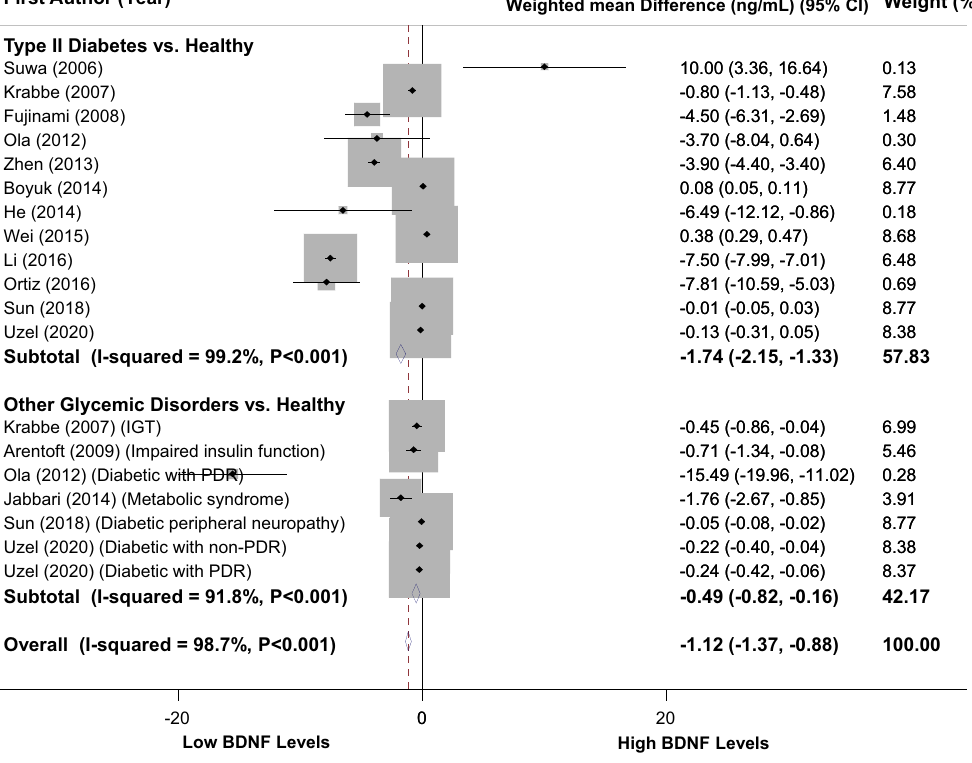
of 1306 diabetic or other glycemic disorders cases vs. 1250 healthy controls were included in this analysis. Over- all weighted mean difference (WMD) of BDNF levels in patients with T2D (or other glycemic disorders) was 1.12 ng/mL lower than healthy subjects (WMD: − 1.12; 95%CI − 1.37, − 0.88), which was statistically significant. Heterogeneity between included studies was observed (I 2 = 98.7%, P < 0.001); therefore, subgroup analysis based on the type of glycemic disorders was done (Fig. 2). In patients with T2D, BDNF levels were lower than healthy controls (WMD: − 1.74 ng/mL; 95%CI − 2.15, − 1.33). Also, subjects with other glycemic disorders had lower blood BDNF values than healthy controls (WMD: − 0.49 ng/mL; 95%CI − 0.82, − 0.16); however, significant heterogeneity was found in both subgroups (I 2 = 99.2%, P < 0.001 and I 2 = 91.8%, P < 0.001, respectively). Subgroup analyses based on other variables [including BDNF matrices (serum vs. plasma), Asian vs. non- Asian countries, age of ≥ 60 vs. < 60, and high quality vs. low quality] were conducted and the findings are reported in Table 2. These stratified analyses could not significantly explain the between-study heterogeneity. After excluding each included study, no significant difference in heterogeneity was observed. Furthermore, meta- regression analysis based on mean age of participants was conducted; but heterogeneity remained unchanged